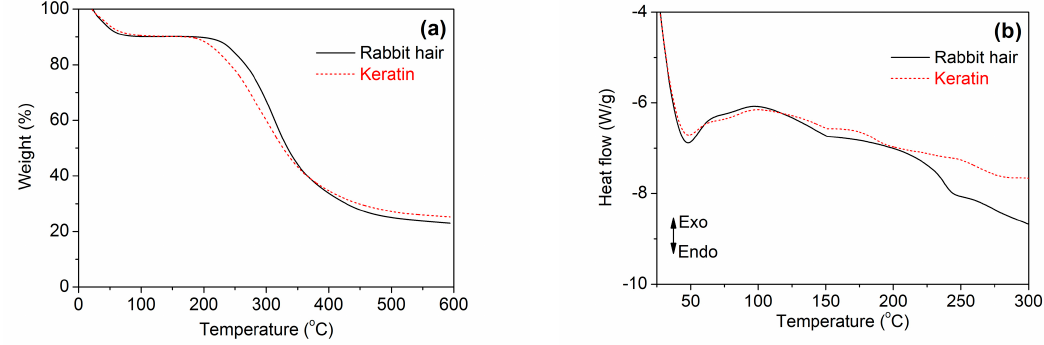
Figure 6. TG ( a ) and DSC ( b ) curves of rabbit hair and regenerated keratin by dissolving in DES at 120 °C. In the DSC curves of Figure 6b, the raw rabbit hair had an endothermic peak at 242 °C, which is assigned to the melting and destruction of α -helical crystallites [13,37]. However, the same peak